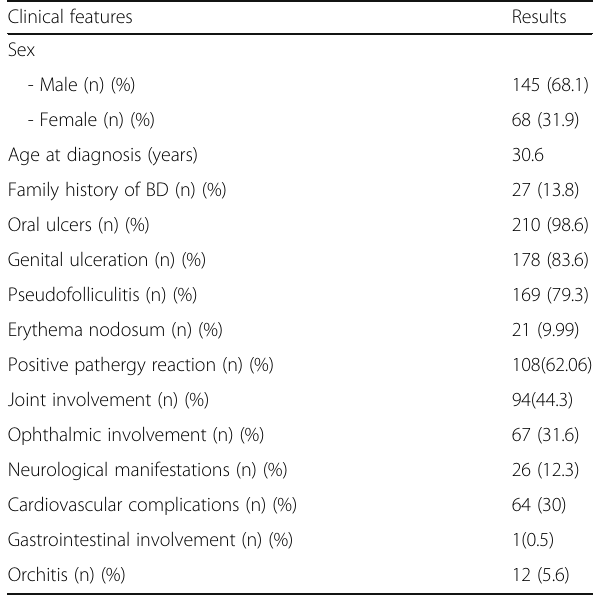
Table 1 clinical features of patients with Beçet